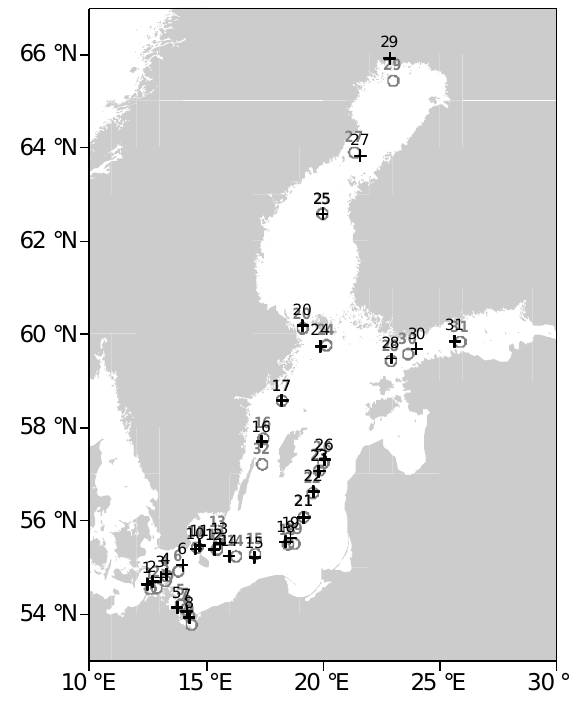
Figure 4. Station map for the comparison of isotope patterns in the water column and sediments. Gray circles are the stations referred to in Voss et al. (2005) and black crosses are those from this study. Isotope values were compared at stations with the same